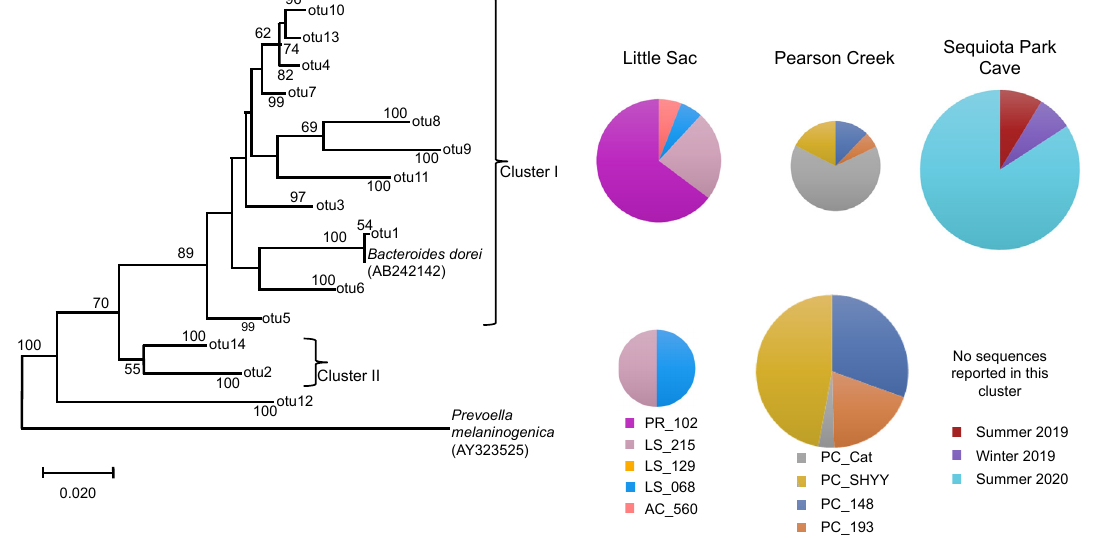
Figure 4. Neighbor-joining phylogenetic tree of partial 16S rRNA gene sequences (370 bp) related to the Bacteroidaceae family from three impaired watersheds. Only OTUs (operational taxonomic units) containing ≥ 50 sequences were used in this analysis. The DNA sequences of Bacteroides dorei that is used a marker organism for human fecal contamination in water was also included in the phylogenetic analysis. The size of the pie chart is proportional to the number of sequences within a cluster. The size of a pie chart can only demonstrate the variation in sequences within a given watershed, e.g., a pie chart from the LSW site cannot be compared with pie charts from Pearson creek due to the differences in the sampling time and number of DNA sequences retrieved across different watersheds. Numbers at the node reflect the bootstrap values.